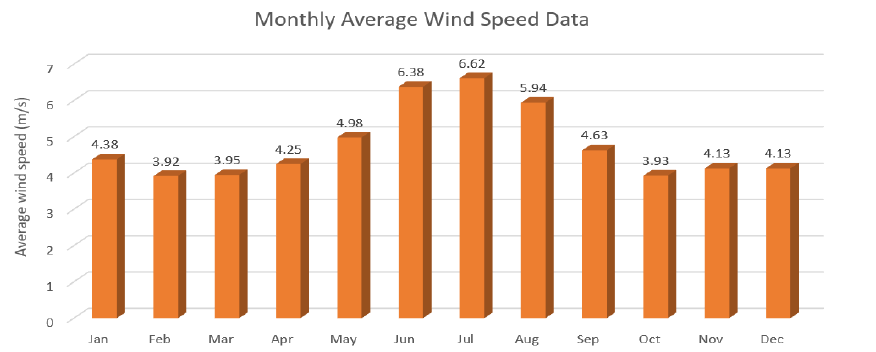
Figure 5. Monthly average wind speed